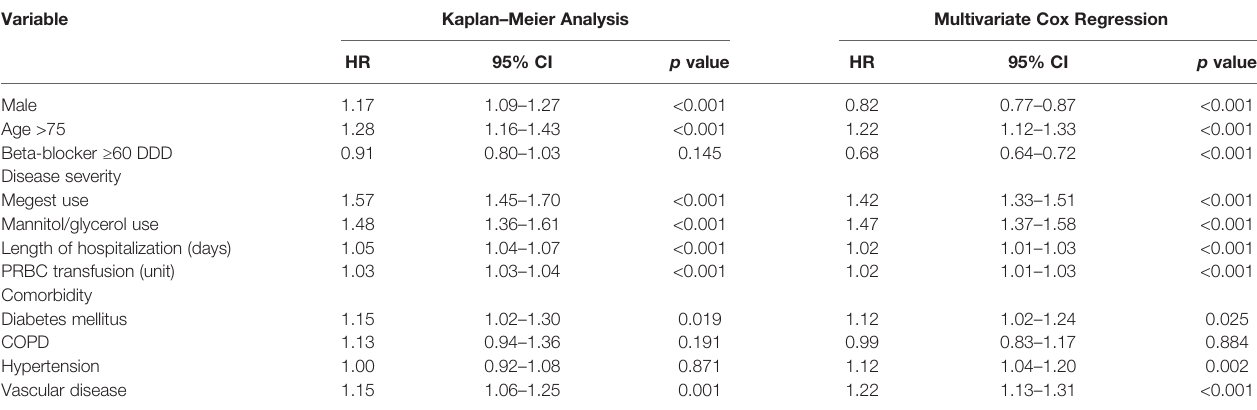
Multivariate Cox regression adjusted for sex, age, disease severity, and comorbidities, including COPD, diabetes mellitus, end-stage renal disease, hypertension, heart disease, ischemic heart disease, cerebral vascular disease, and peripheral artery